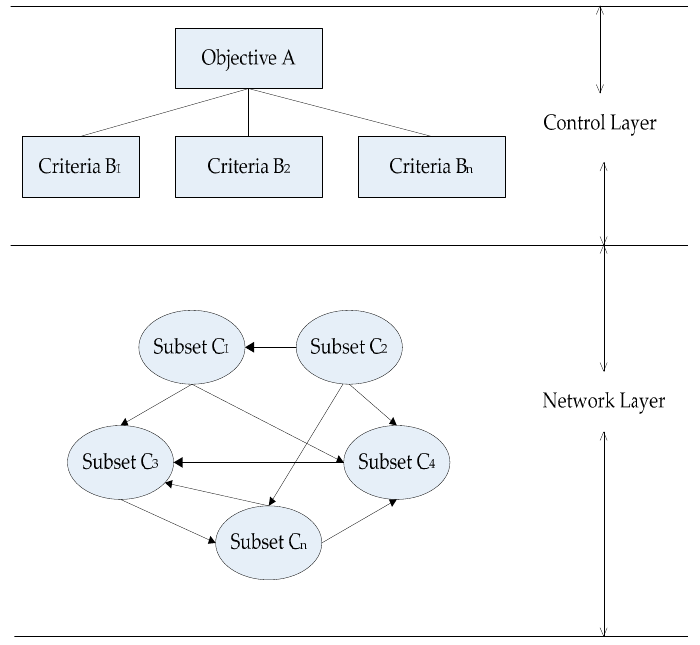
Figure 7. Typical ANP hierarchy.